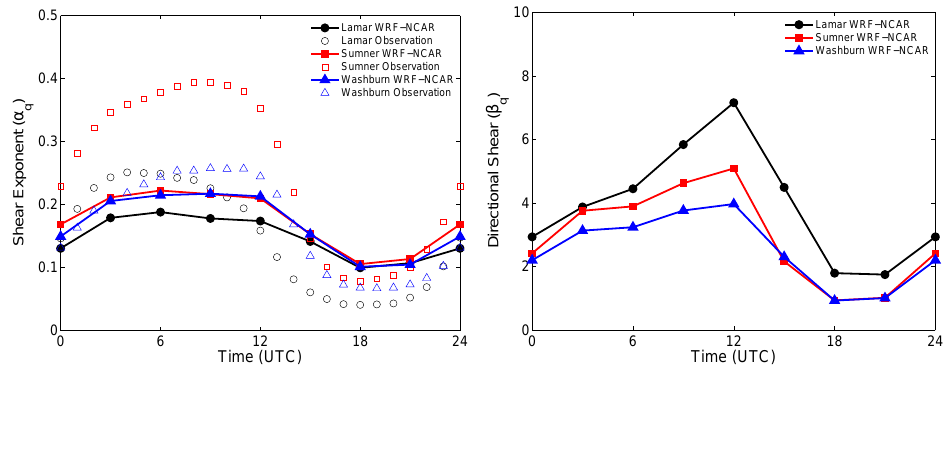
Figure 7. Diurnal variation of the observed and the WRF-NCAR model forecast-derived annual average wind shear exponents (left panel) and the directional shear magnitudes (right panel). Observed shear exponents are reproduced from SE06 using Engauge Digitizer 4.1. Study period: April 2006–March